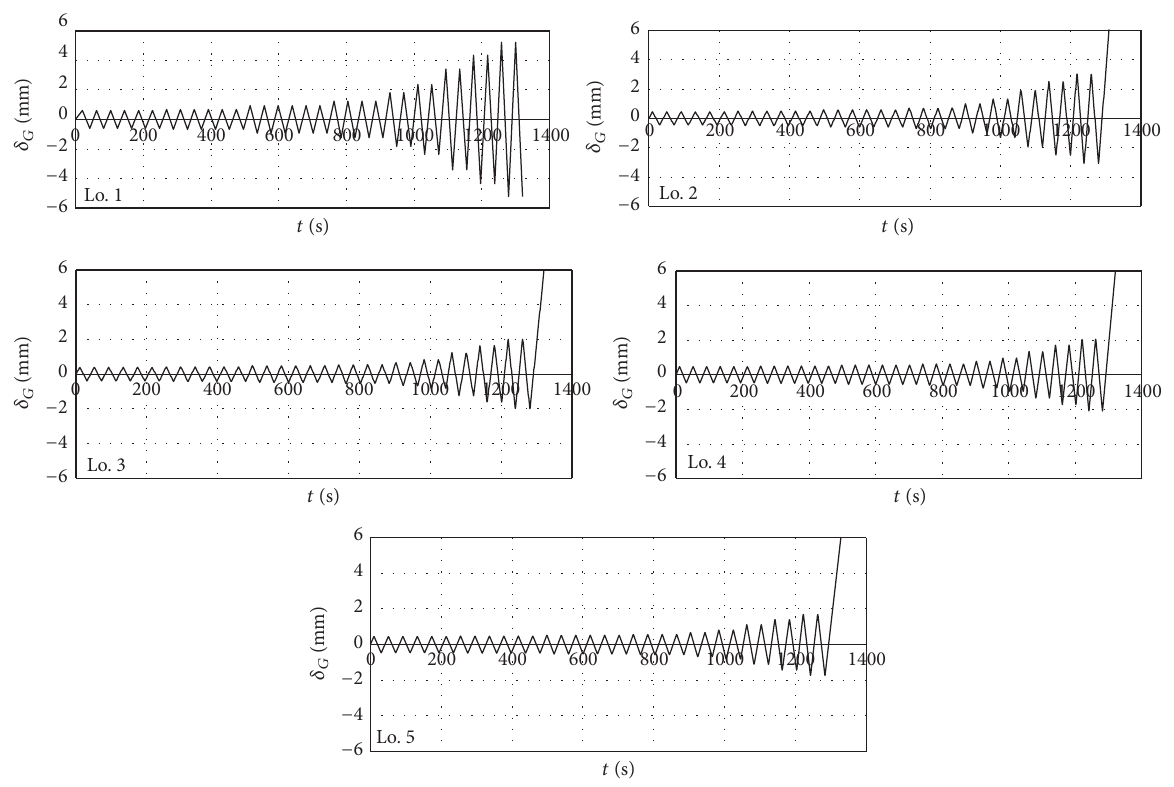
Figure 4: Cyclic loading histories according to SAC 2000